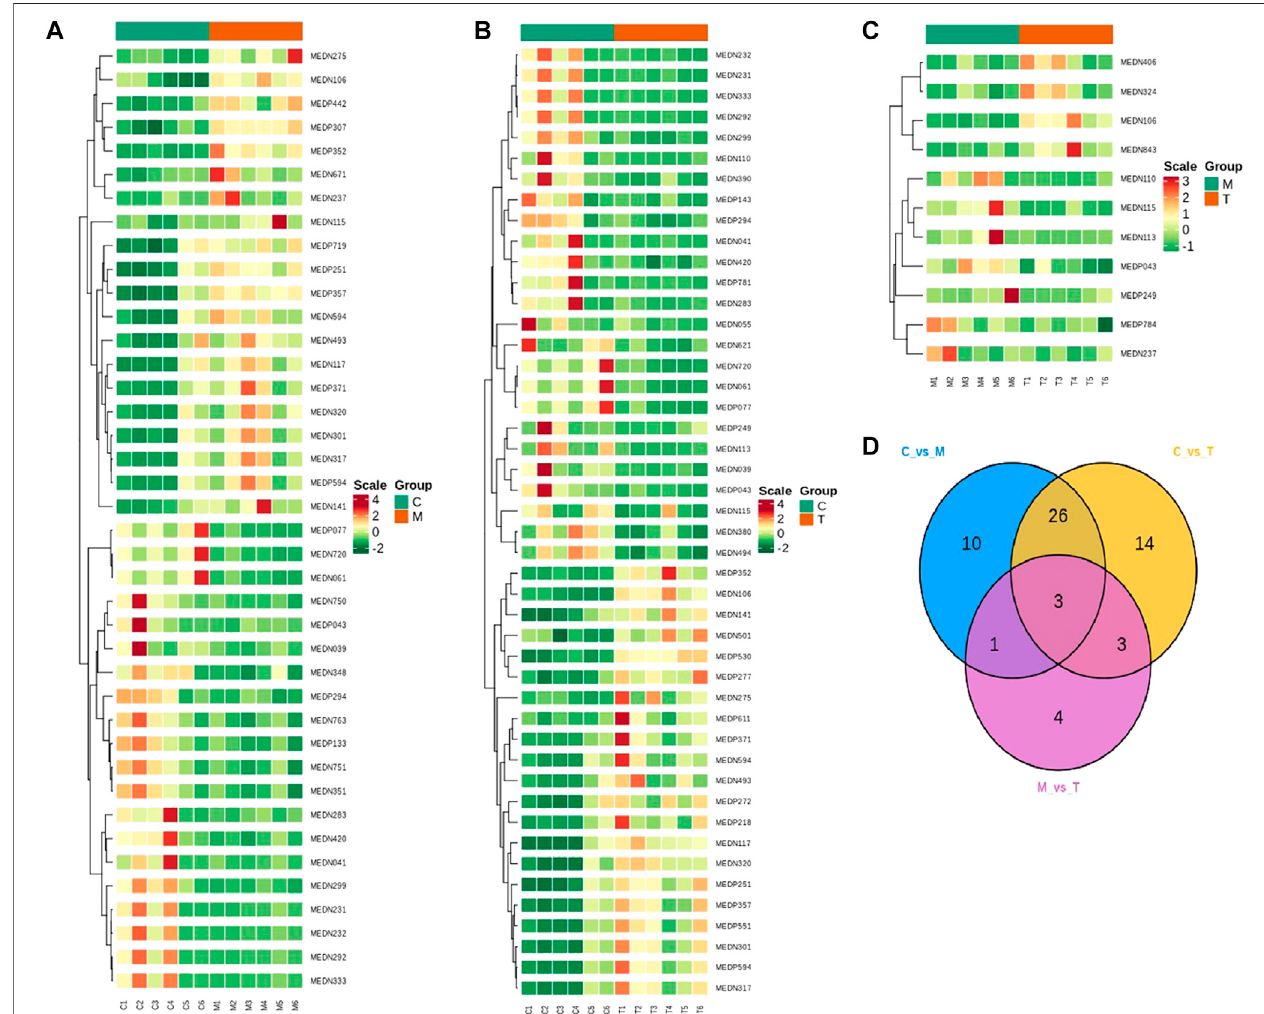
FIGURE 3 | C is the CTL group; M is the PLC group; and T is the JWXY group. (A) Clustering heat map of metabolites with signi fi cant difference between the CTL group and PLC group. (B) Clustering heat map of metabolites with signi fi cant difference between the JWXY group and CTL group. (C) Clustering heat map of metabolites with signi fi cant difference between the JWXY group and PLC group. Red indicates a strong positive correlation, and green indicates a strong negative correlation. (D) Venn diagram of differential metabolites between groups.